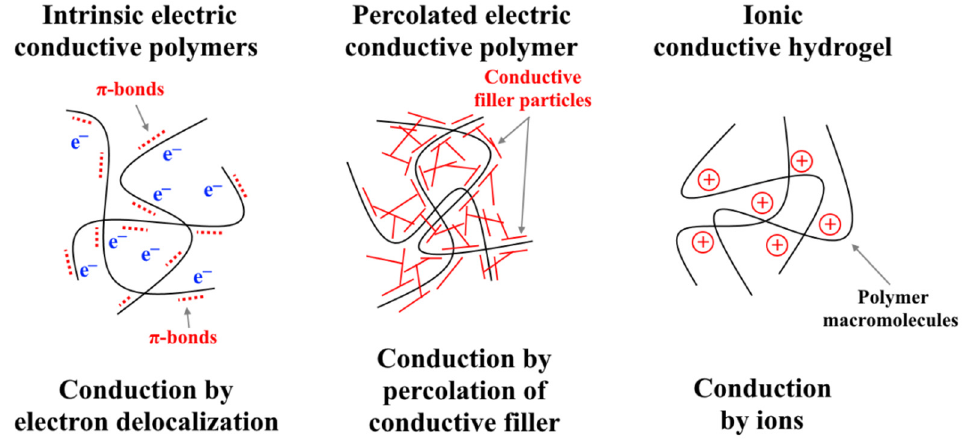
Figure 14. Conduction mechanisms of electroactive